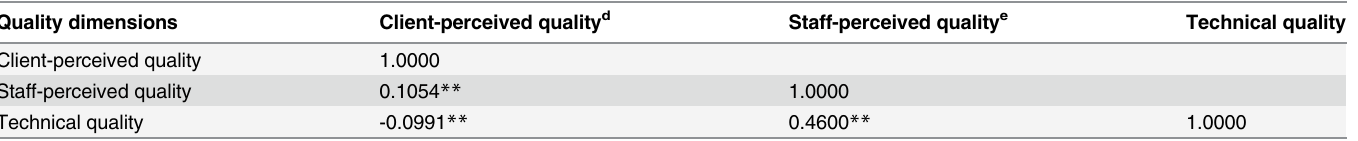
Table 4. Association between perceived and technical quality